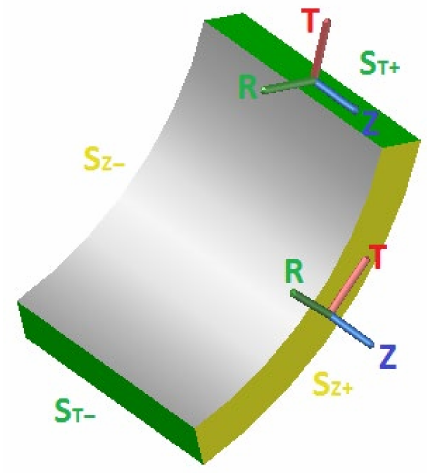
Figure 5. Definition and coordinates of the